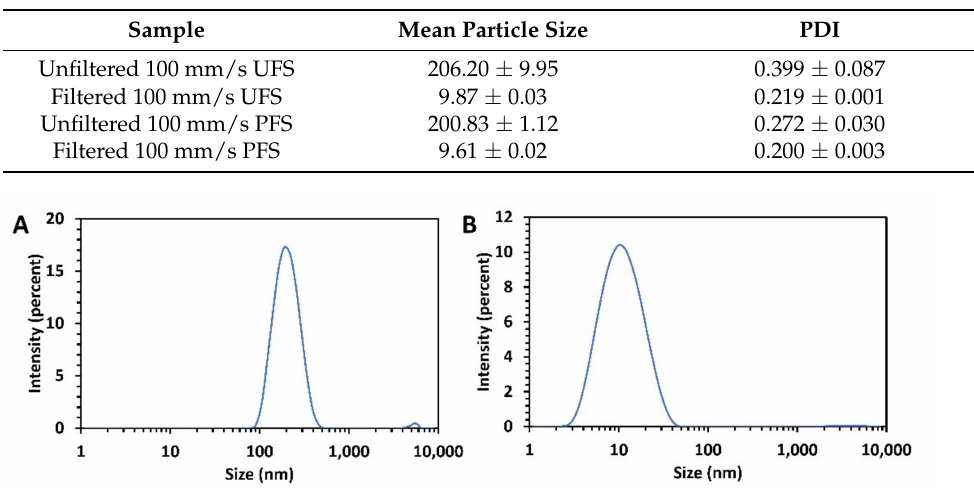
Table 2. Mean particle size distribution in filtered and unfiltered dissolution medium.